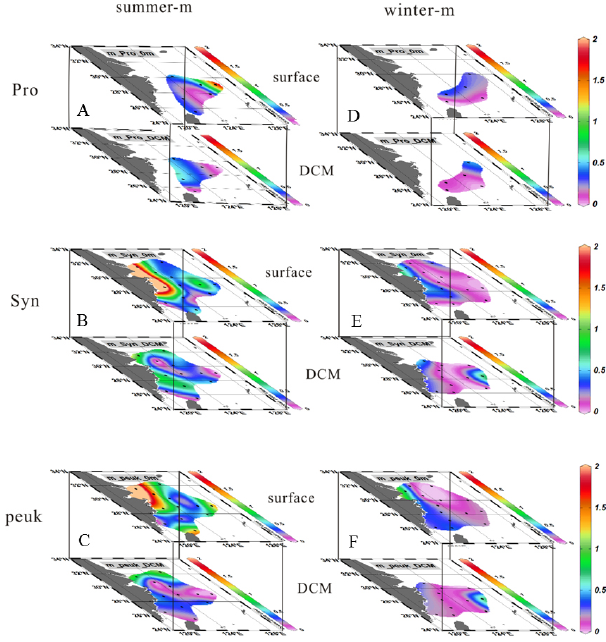
Fig. 6a. Spatial pattern of the growth rate ( µ ) of the three picophyto- plankton populations in (A–C) summer and (D–F) winter. The two layers are surface and deep chlorophyll maximum (DCM) layer.